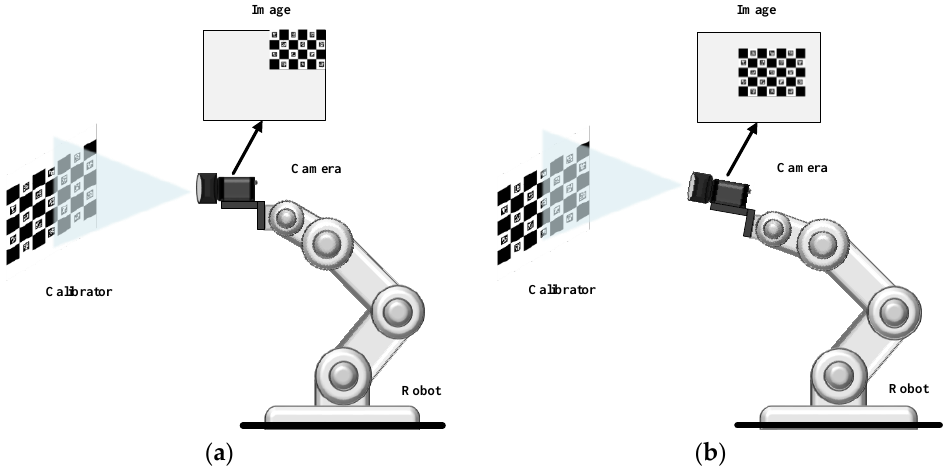
Figure 8. ( a ) Image captured by camera before robot adjustment; ( b ) Image captured by camera after robot adjustment.